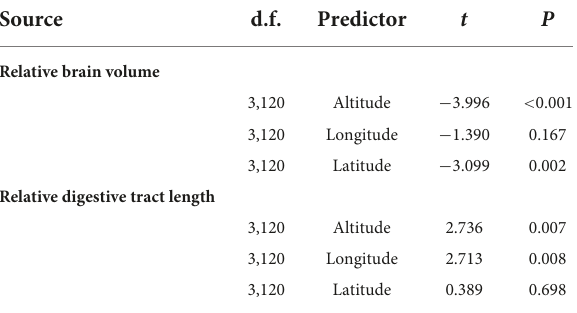
TABLE 2 The effects of geographical gradients on variation in relative brain volume and relative digestive tract length of the Feirana quadranus using multiple linear regression model